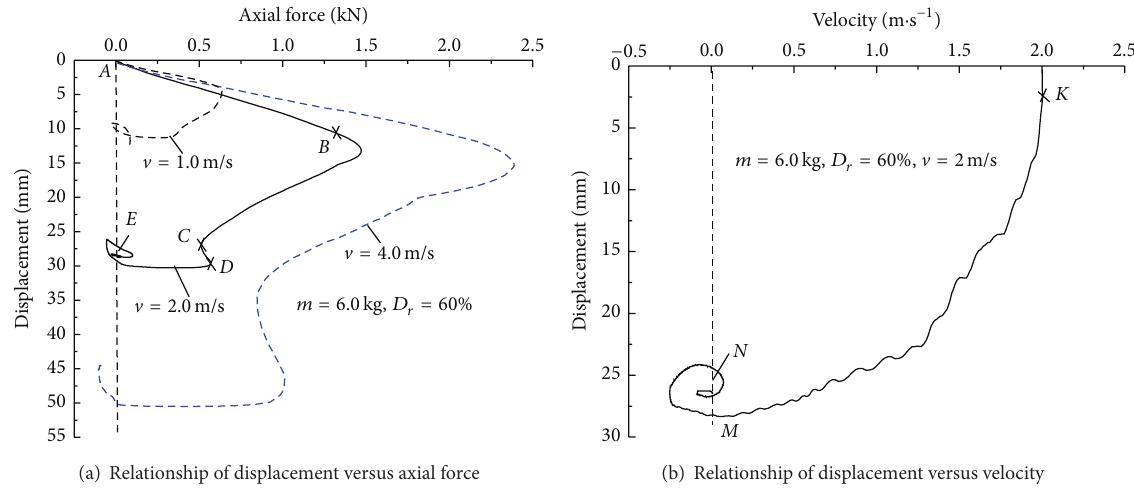
Figure 15: Test result of 𝐷 𝑟 = 60 %, 𝑚 = 6